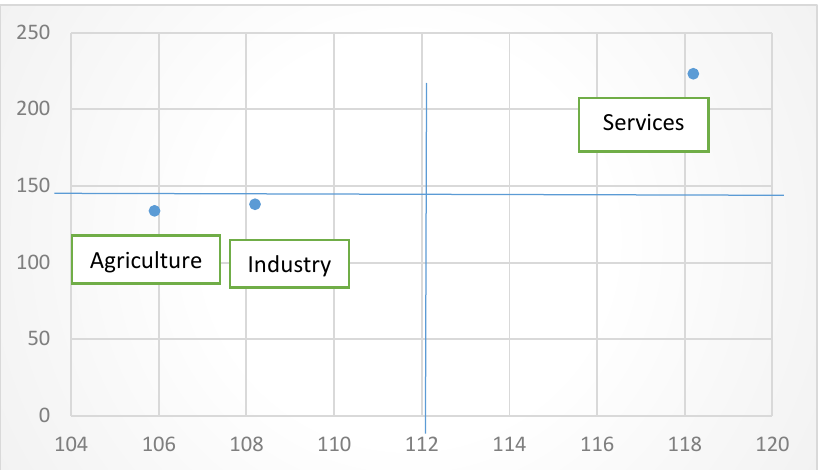
Figure 3. The changes of the three economic sectors of Sistan & Baluchestan in Izard model Source: Authors,